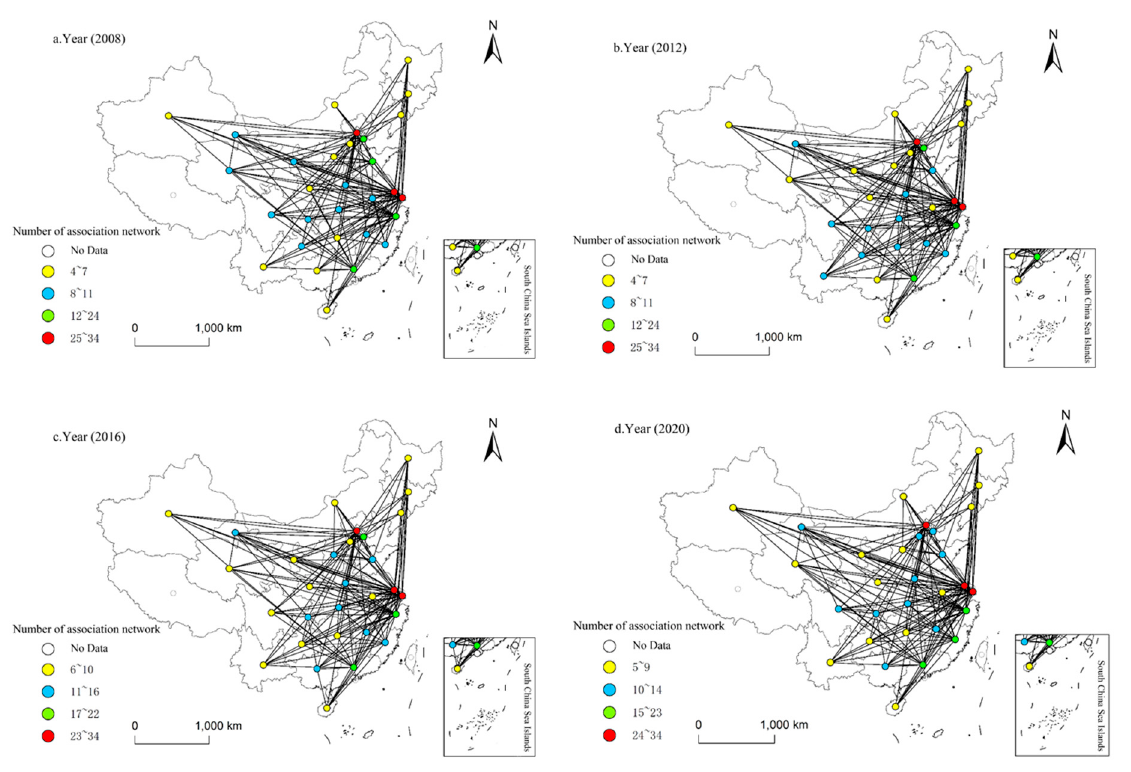
Figure 6. The spatial association network of regional economic growth in China. ( a ) Year 2008; ( b ) year 2012; ( c ) year 2016; ( d ) year 2020. Data source: calculated by the social network analysis according to the variables in Table 2.